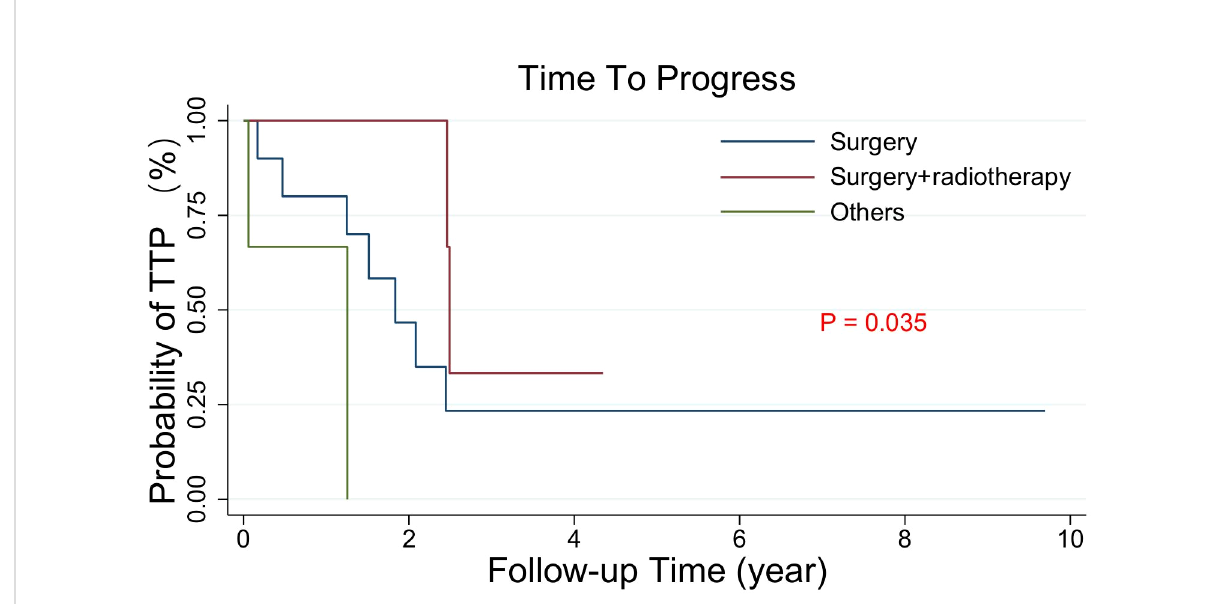
FIGURE 3 Kaplan − Meier estimated the TTP curves of 22 intracranial SFT/HPC patients with relapse after PORT who received different treatments again (Ssurgery, surgery plus radiotherapy, others). The others included 3 patients who received radiotherapy alone and 1 patient who received symptomatic treatment. The TTP of the surgery and surgery plus radiotherapy groups was similar, but different from that of the other groups (p = 0.003).